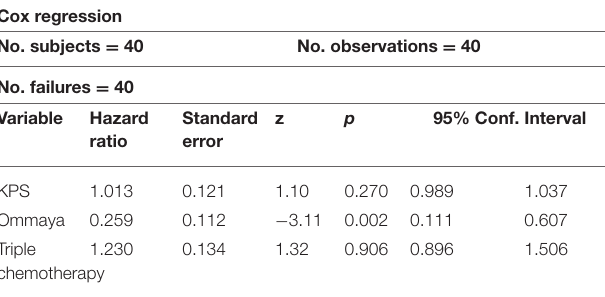
TABLE 3 | Favorable prognostic factor in Leptomeningeal carcinomatosis by Cox regression